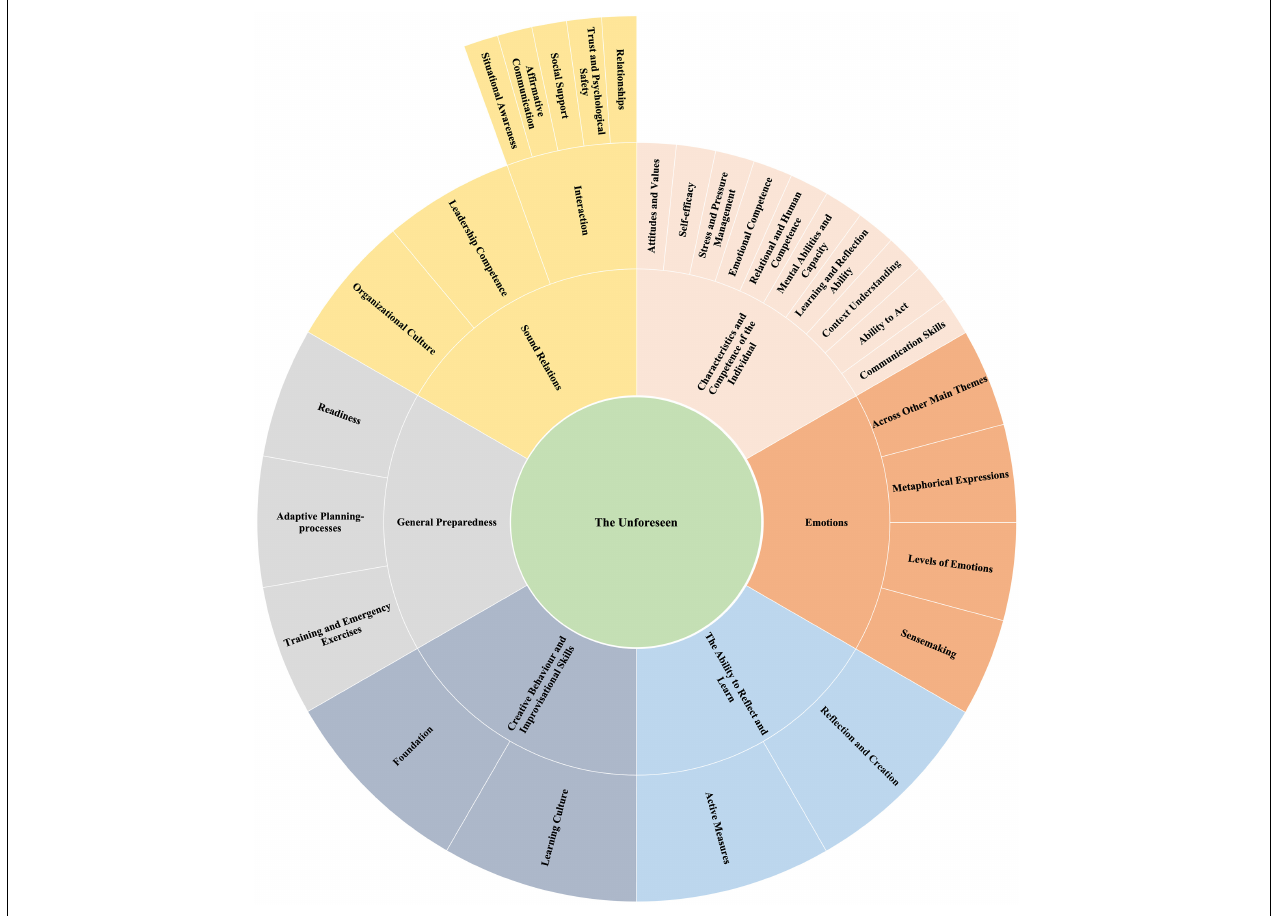
FIGURE 2 | Sunburst map of the seven main themes, including sub-themes and sub-sub-themes. The map also represents a panarchy of three adaptive cross-level cycles (Holling and Gunderson, 2002) based on the main types of competence, units of competence, and elements of competence (Burke, 1990; Truelove, 1995).